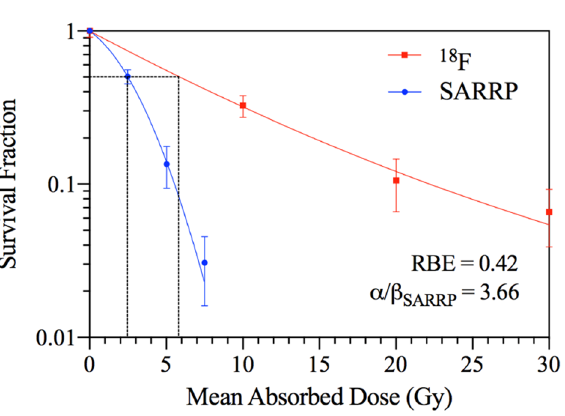
Figure 1. β + track deposits energy in water in through the formation of “spurs” and the terminal “blob”, before a positronium (Ps) formation and annihilation to generate the 0.511 MeV photons.